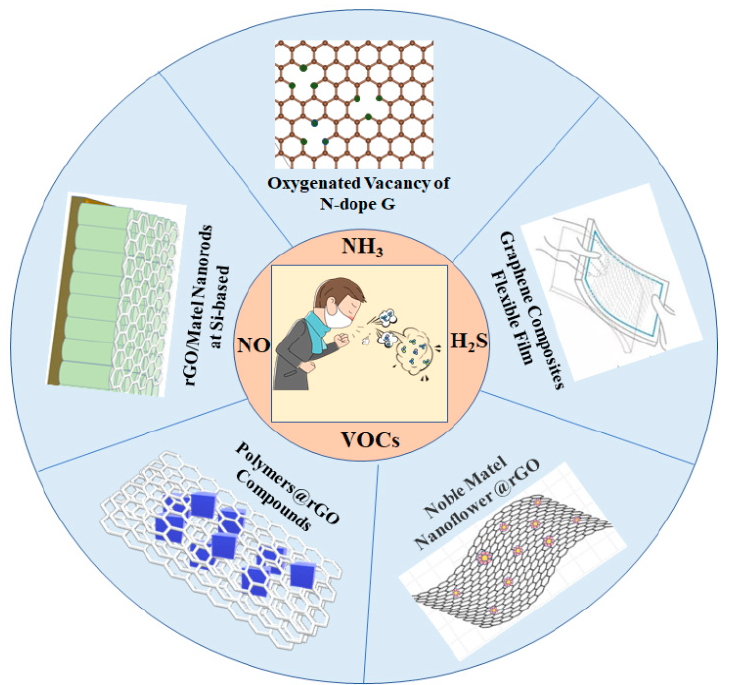
Figure 1. Different disease biomarkers of exhaled air identified by graphene-based composites.